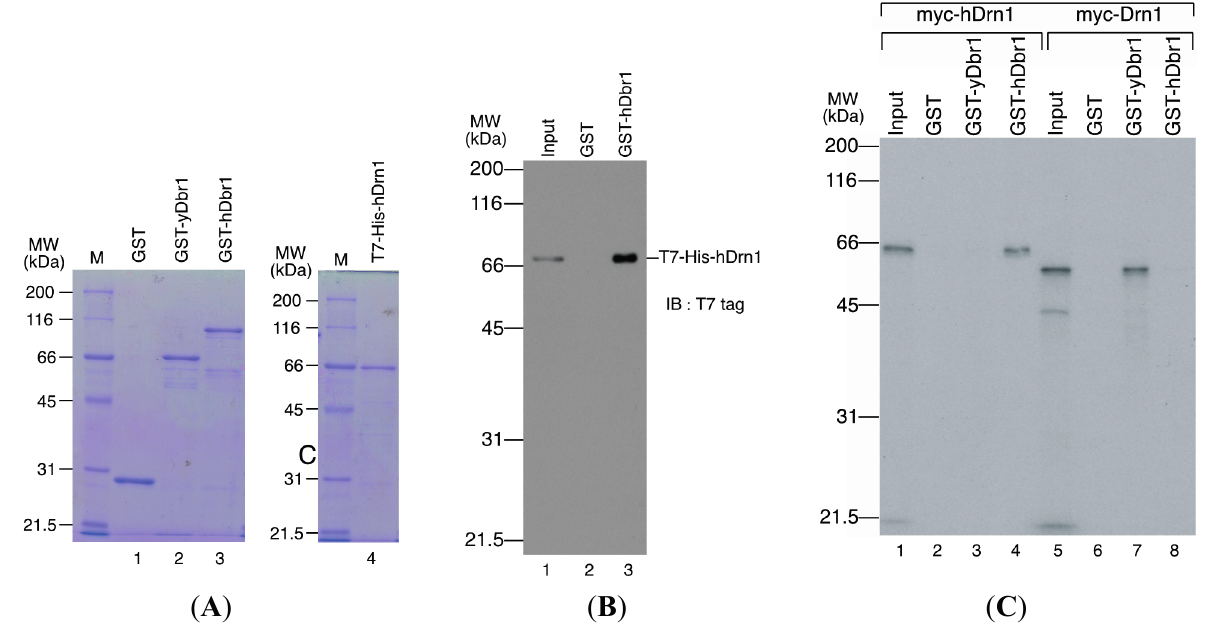
Figure 5. hDrn1 binds directly with hDbr1 and the binding of these proteins is conserved among species. ( A ) Proteins used for in vitro binding assays. GST, GST-yeast Dbr1 (GST-yDbr1), GST-hDbr1 and His-hDrn1 were overexpressed and purified from E. coli cells. Two micrograms of each protein was separated using 12.5% SDS-PAGE gels and stained with Coomassie Brilliant Blue. The molecular mass markers are also shown on the left of the gels with the sizes in kDa; ( B ) Direct binding of hDrn1 with hDbr1 in vitro . Two micrograms of purified His-tagged hDrn1 was incubated with 5 μ g each of GST or GST-hDbr1. Bound proteins were separated by 12.5% SDS-PAGE and detected by Western blotting with anti-T7 tag antibody (Novagen). The molecular mass markers are also shown on the left of the gels; and ( C ) Specific binding between Dbr1 and Drn1 is conserved between yeast and humans. The myc-tagged yDrn1 and hDrn1 proteins were produced and labeled with [ 35 S]methionine in vitro . Those proteins were incubated with 5 μ g each of GST, GST-yDbr1 or GST-hDbr1. After precipitation and washing, bound proteins were eluted, separated on 12.5% SDS-PAGE gel and visualized by fluorography. The lanes marked Input contain 10% of the total protein used in each binding reaction. The position of the molecular mass markers is shown on the left of the panel in